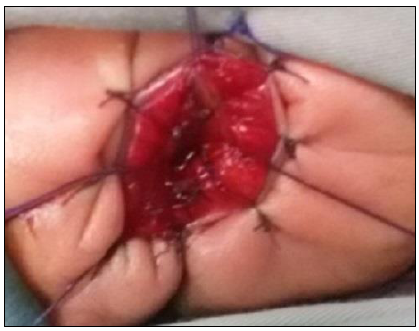
Figure 2: After transanal excision of web